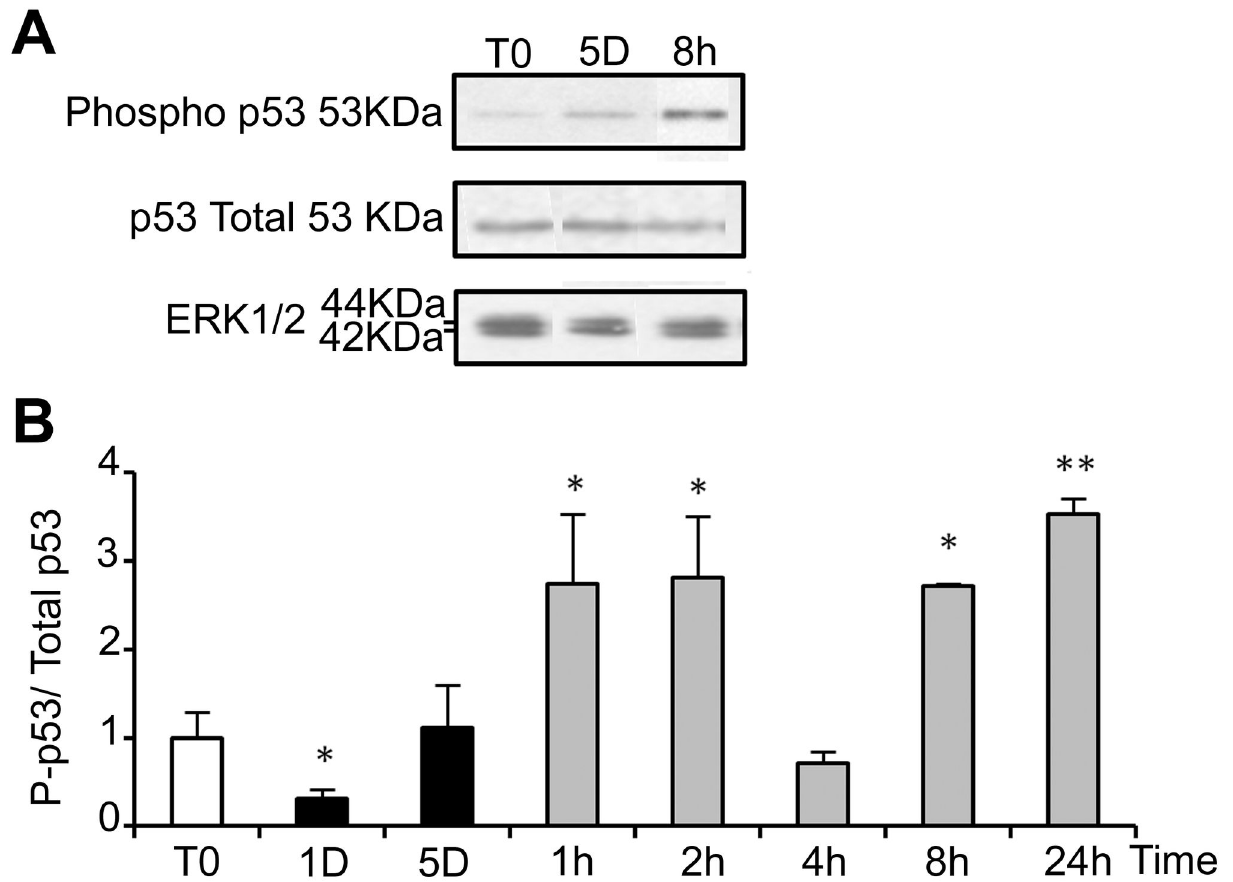
Figure 8. Return to normal temperature after a cold shock affects the phosphorylation of p53. Total and phosphorylated p53 (P-p53) were analyzed in WI26 cells cultured in normal conditions or at 25°C for 1 and 5 days and then warmed-up at 37°C for 1 to 24h. (A) Representative western blot. (B) Quantifications of the western-blots are expressed as the mean ratio P-p53/total p53, taking T0 as 1. Total protein loading was monitored by ERK1/2.